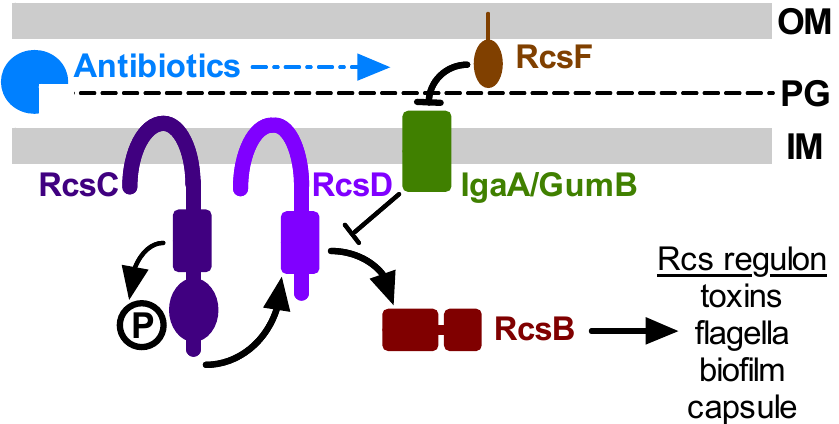
Figure 1. Model for antibiotic activation of the Rcs system. This simplified depiction of the core Rcs system shows the major components required for Rcs function. The Rcs system is a complex phosphorelay signal transduction system that regulates the transcription of many genes through control of the RcsB transcription factor. The IgaA/GumB inner membrane protein blocks Rcs activity under non-stressful conditions. Envelope stress by antibiotics, transmitted by RcsF, prevents IgaA/GumB inhibition of RcsC-D and allows RcsB-mediated transcription. Mutation of igaA / gumB constitutively derepresses the Rcs transcriptional cascade, and mutation of rcsB prevents Rcs system function. This model predicts that Rcs activation by antibiotics can stimulate pathogenesis and antibiotic tolerance phenotypes. OM: outer membrane; PG: peptidoglycan; IM: inner membrane.